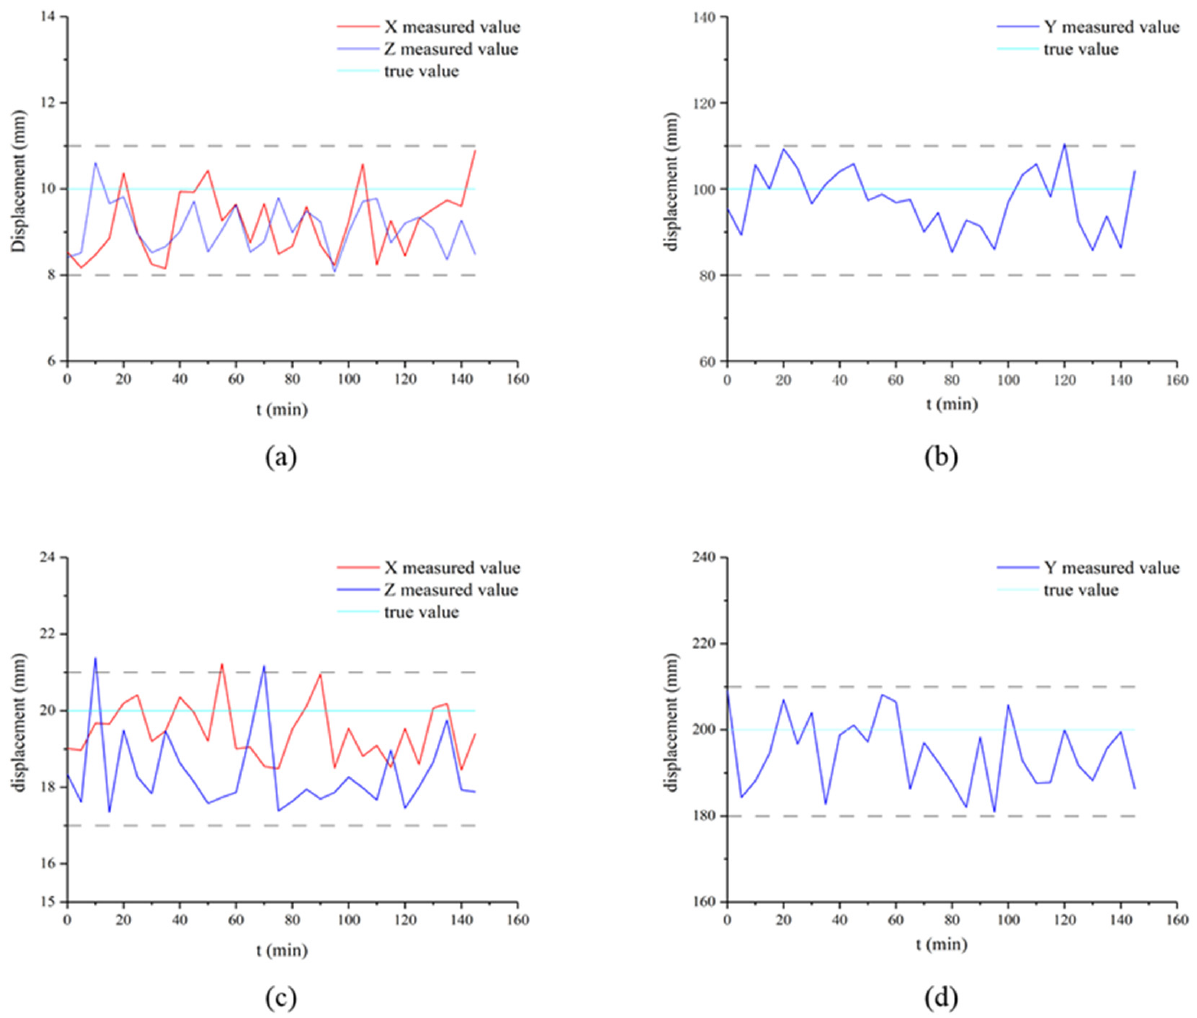
Figure 8. Calculation results for the fixed camera. ( a ) The result of the landmark moving 10 mm in X and Z axes. ( b ) The result of the landmark moving 100 mm in Y axes. ( c ) The result of the landmark moving 20 mm in X and Z axes. ( d ) The result of the landmark moving 10 mm in Y axes. When the true values on the X and Z axis were 20 mm, the RMSE in the X direction was 0.91 mm and that in the Z direction was 1.91 mm. When the true value on the Y axis was 200 mm, the corresponding root mean square error was 9.82